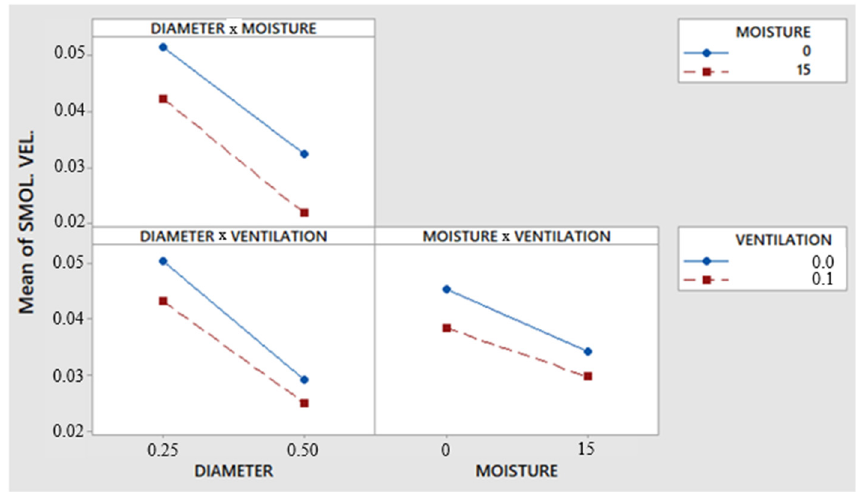
Figure 10. Interaction plot for smoldering velocity.